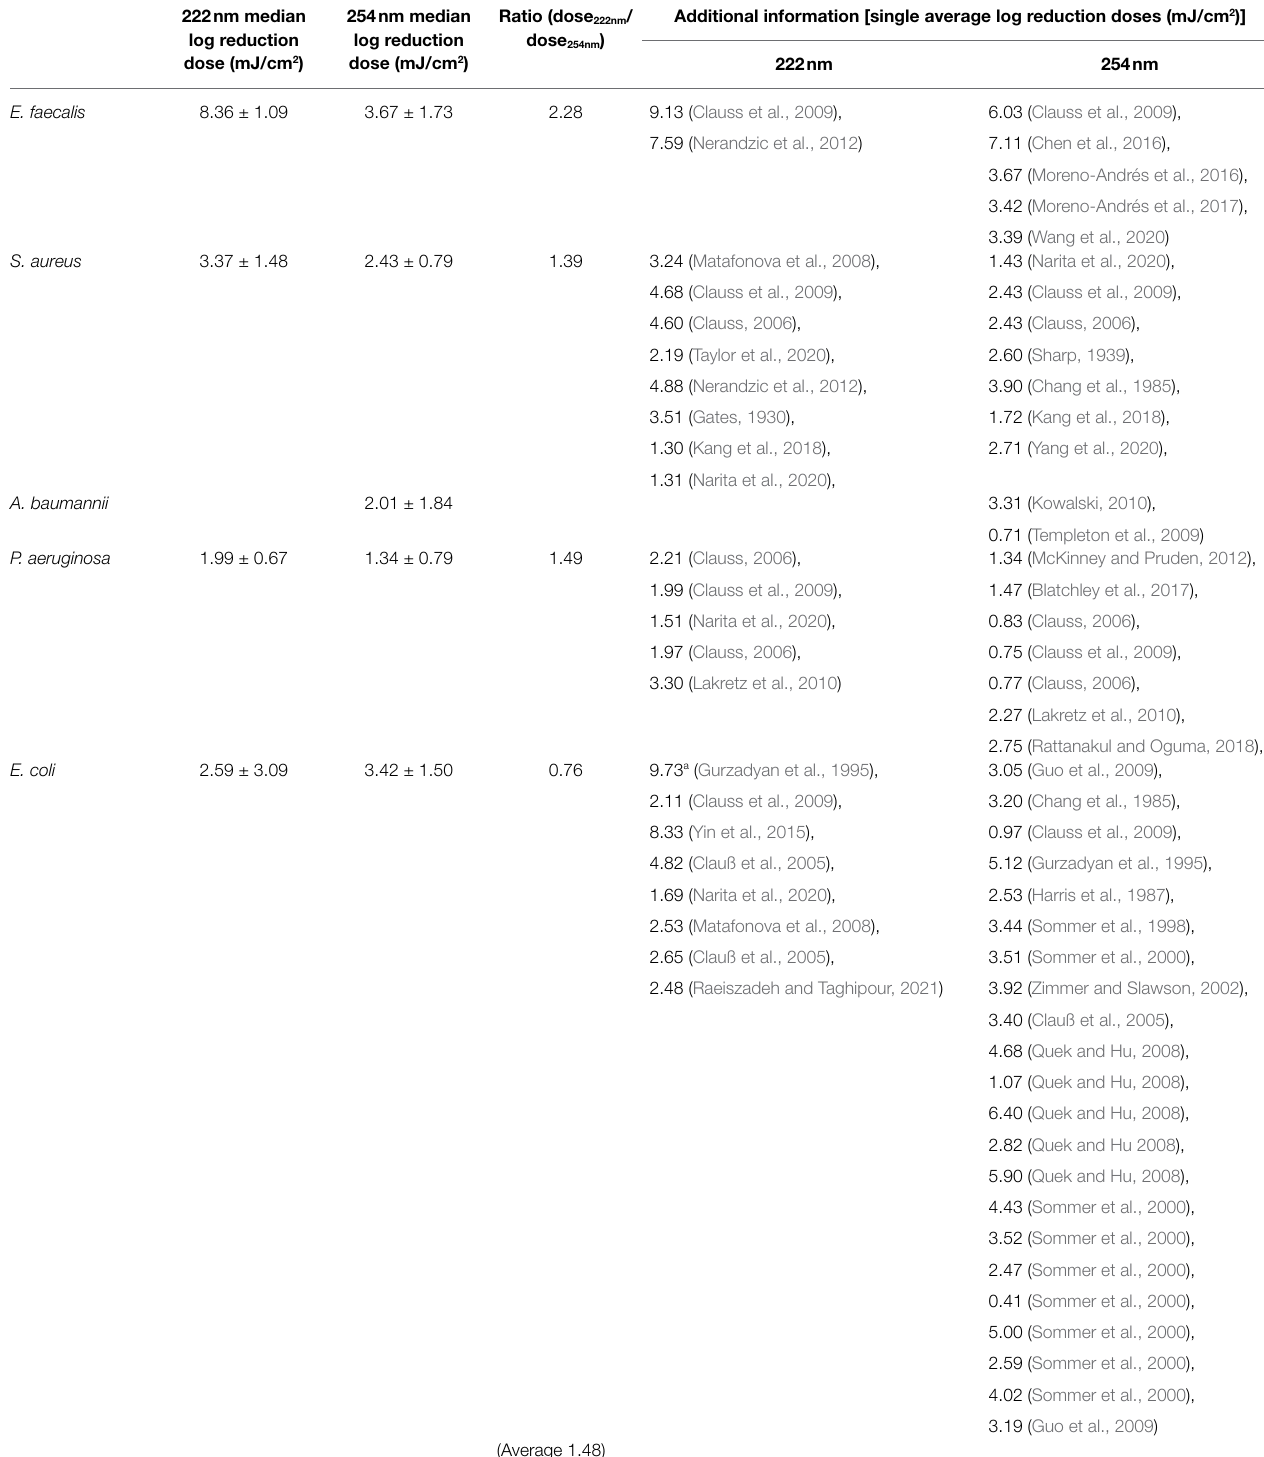
TABLE 2 | Overview of median log reduction doses for ESKAPE pathogens retrieved from literature. 222 nm median log